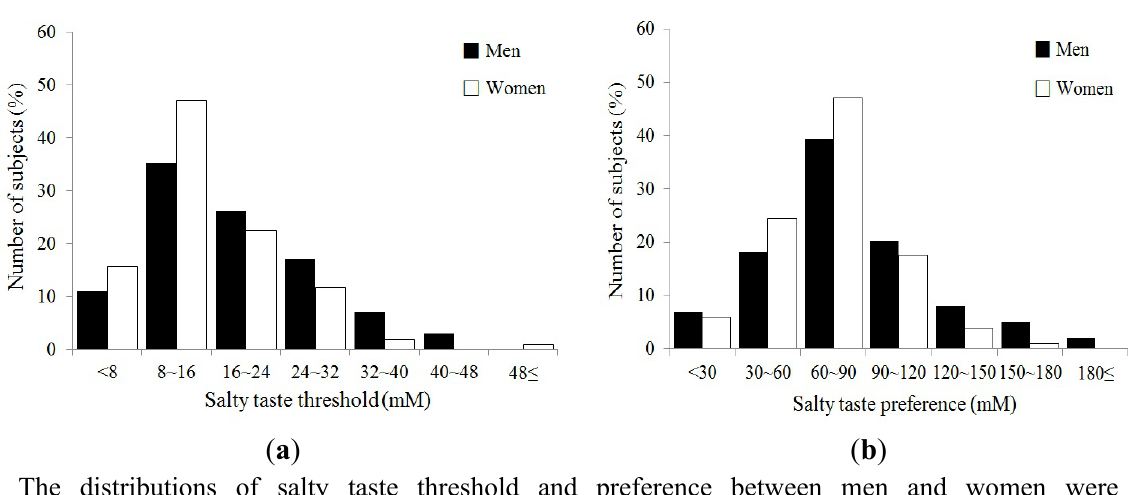
Figure 1. Distribution of salty taste threshold ( a ) and preference ( b ) in men and women.